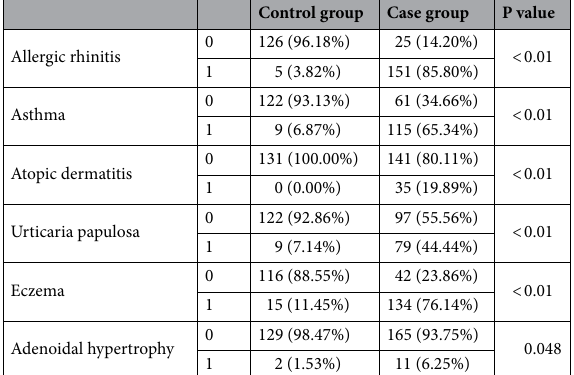
Control group Case